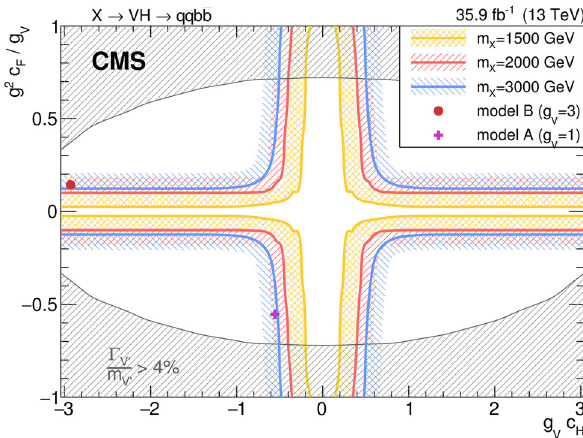
Fig. 1 CMS [21], observed 95% CL exclusion contours in the HVT parameter space g V c H ,( g 2 / g V ) c F for narrow resonances of mass 1.5 TeV, 2.0 TeV and 3.0 TeV. Due to the narrow width approximation assumption, the exclusion validity is restricted to roughly | g V c H | ≤ 3 and outside the hatched area shown, thus leaving a large part of the available phase space unconstrained (3 < | g V c H | < 4 π ). Similar lim- its have been published by ATLAS